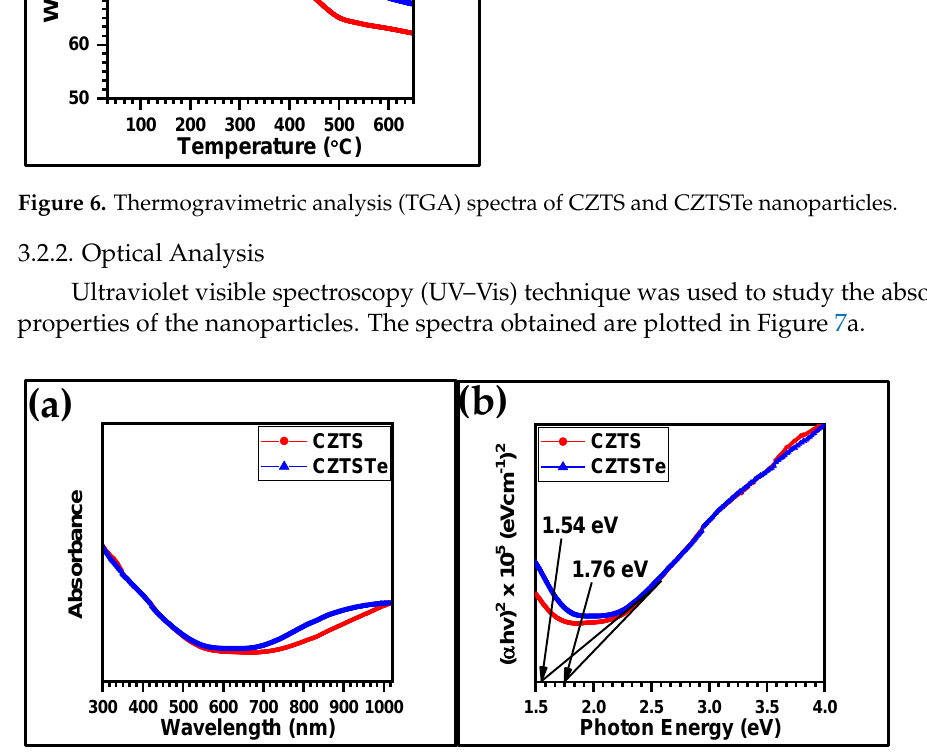
Figure 7. ( a ) UV–Vis absorption spectra and ( b ) Tauc plots for CZTS and CZTSTe nanomaterials. For direct band gap materials such as kesterites, the Tauc plot (i.e. ( αh ) 2 vs. h , where